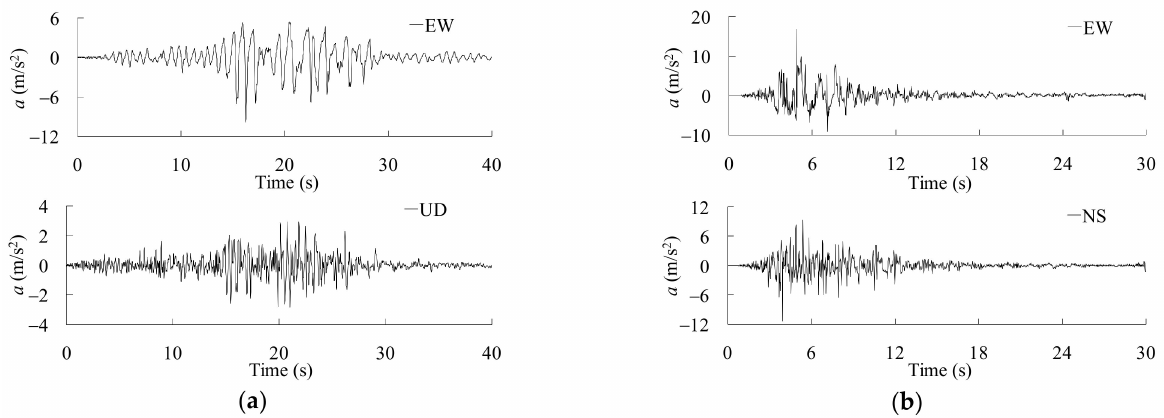
Figure 15. Accelerations of the input earthquakes: ( a ) Chi-chi (1999) earthquake recorded at Sun Moon Lake station; ( b ) Niigata (2004) earthquake recorded at Kawaguchi